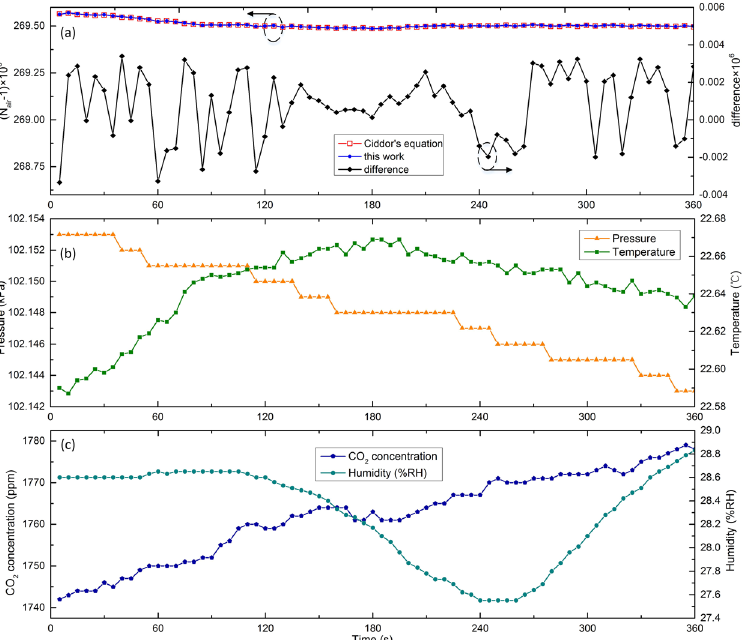
Figure 3. Short-term measurement data of group refractive index of ambient air. ( a ) Comparison between the measurement data and computed value from n p ( v ) + ( dn p ( v )/ dv ) v ( n p is obtained by the Ciddor’s equation). The arrow direction points out appropriate y axis. ( b ) Variations of pressure and temperature. ( c ) Variations of CO 2 concentration and humidity.